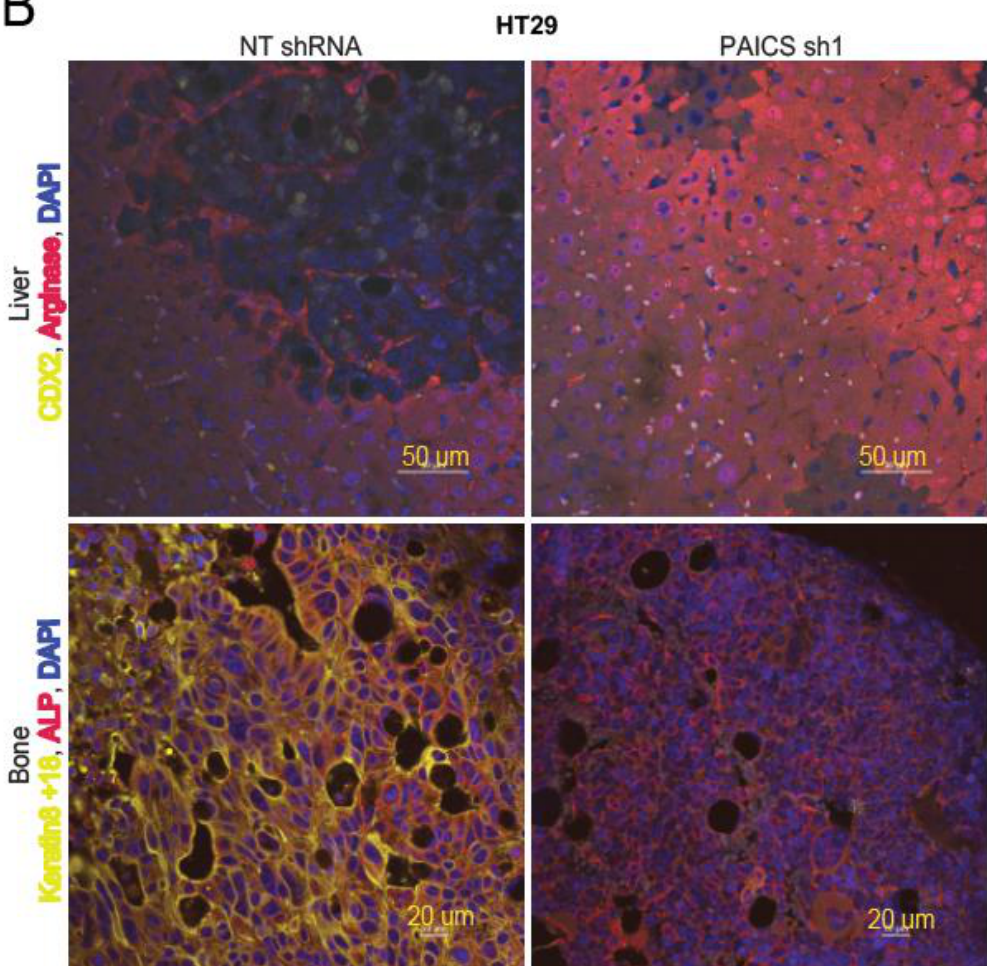
Figure 5. PAICS knockdown decreases the dissemination of CRC lesions to various organs. ( A ) Hematoxylin & eosin (H&E) staining of the hind-limb bones, lungs, and livers of mice injected with cells transfected with NT shRNA or PAICS shRNA. The images were taken at 4×and 20×; scale bar— 20 µm. The arrows show metastatic lesions; BM, bone marrow; B, bone; Lu, lungs; Li, liver. ( B ) Immunofluorescence (IF) co-staining of liver with CDX2 as a marker of cancer cells (yellow) and arginase as a marker for liver cells; scale bar— 50 µm. For bone staining, keratin 8 + 18 was used as a marker of cancer cells (yellow), ALP as a marker of osteoclast lineage (red), and DAPI for nuclear staining (blue); scale bar— 20 µm.